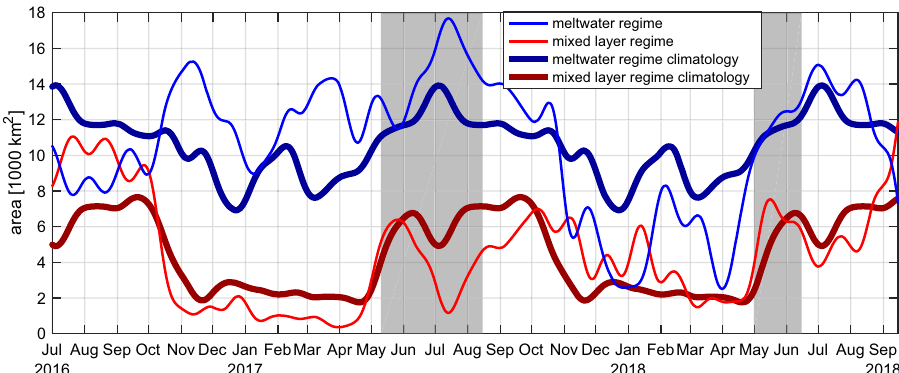
Fig. 9 Areal coverage of strati fi cation regimes from the numerical ocean model. Area covered by different strati fi cation regimes within the 18,500km 2 large region 0°E – 8°E, 78.5°N – 79.5°N (see cyan box in Fig. 1). The meltwater regime ’ s de fi nition in the model is mixed layer depth MLD < 50 m and Δ S > 1 (where Δ S is salinity difference between the surface and 100 m depth). The mixed layer regime ’ s de fi nition is MLD < 50 m and Δ S < 1. The meltwater regime is shown in blue with its climatology in dark blue; it is larger in spring/summer 2017 than typical. The mixed layer regime is shown in red with its climatology in dark red; it is somewhat larger than typical in spring/summer 2018. Unstrati fi ed (MLD > 50 m) conditions make up for the rest of the